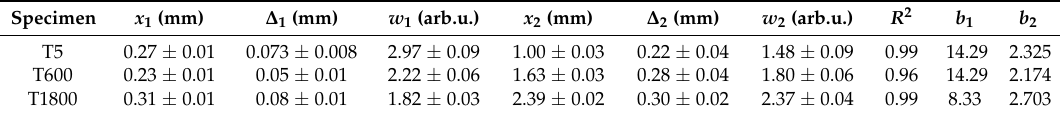
Table 3. Parameters obtained fitting depth profiles to Equation (4) and slope at inflection points obtained from Equation (5).